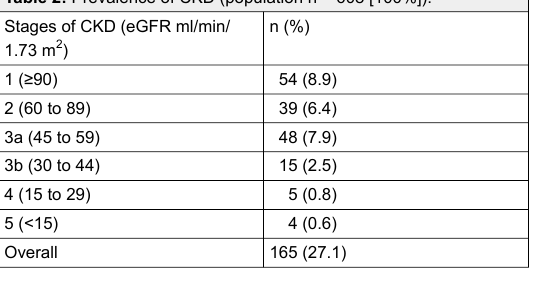
Table 3: Prevalence and degree of proteinuria by dipstick test (population n = 608 [100%]).